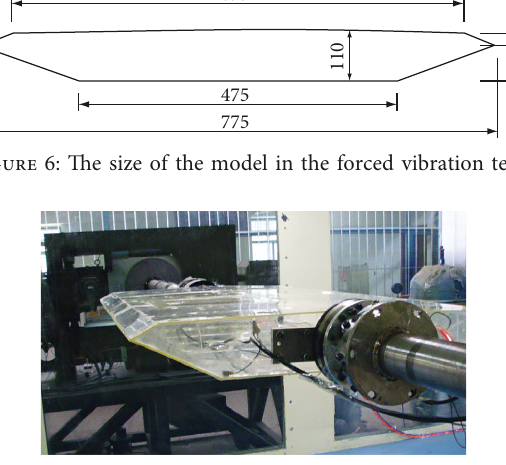
Figure 7: Force vibration